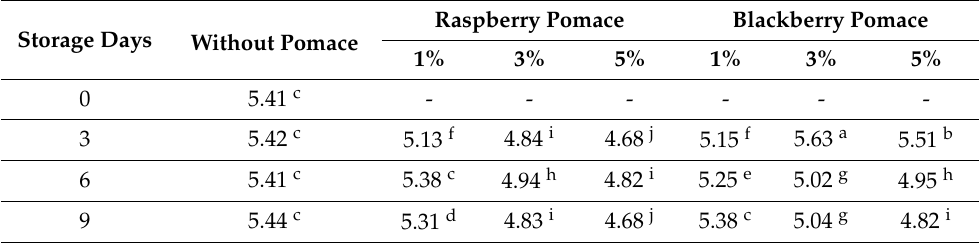
Table 3. Beef patties pH changes during